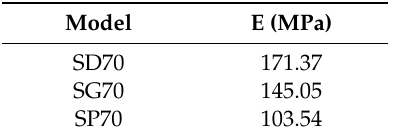
Table 2. Young’s modulus (E) of the TPMS sca ff olds calculated by the homogenization method of Guedes and Kikuchi [18].